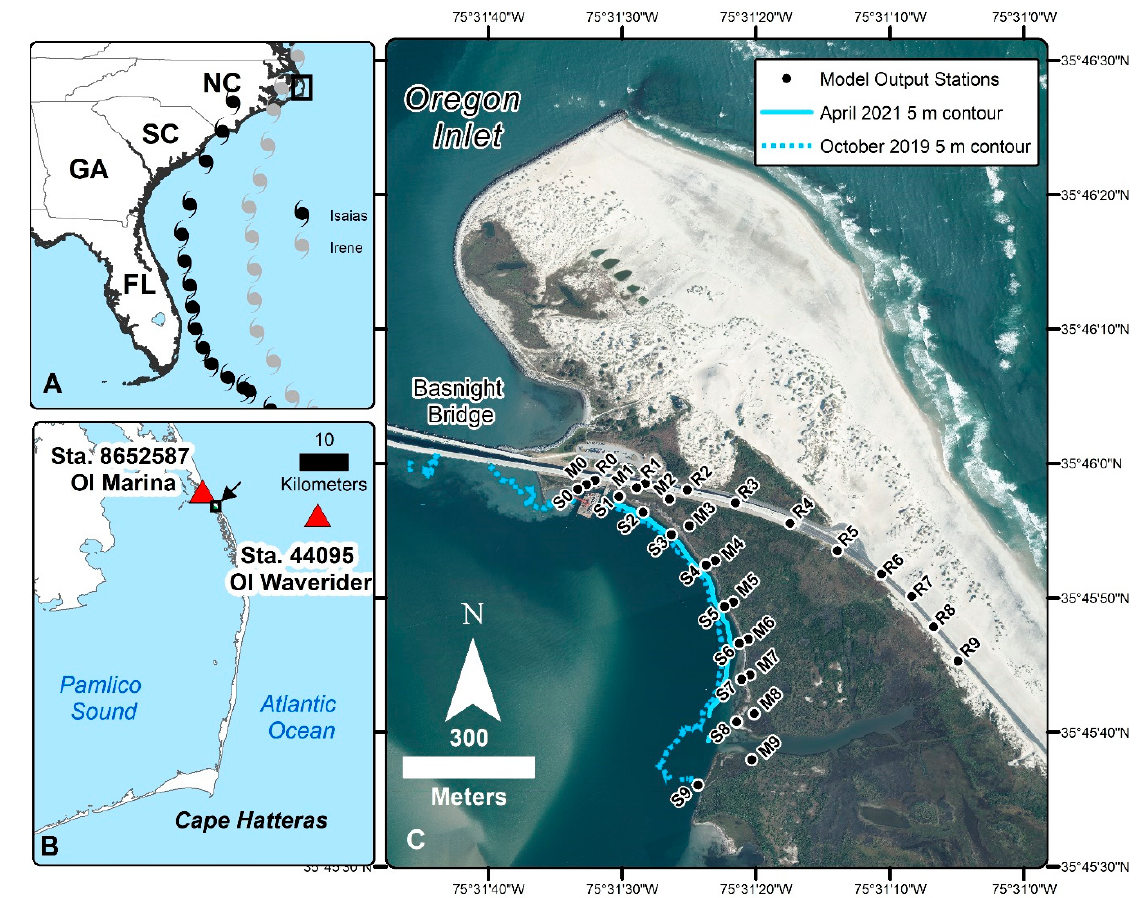
Figure 1. Location of study site along the US East Coast. Region of Panel ( B ) is indicated in panel ( A ); Panel ( B ) shows the location of water level (Sta. 8652587 OI Marina) and wave height (Sta. 44095 OI Waverider) stations employed in this work, with an arrow and black rectangle indicating the location of Panel ( C ). Panel ( C ) shows a detailed view of the study site just south of Oregon Inlet along with the numerical model output stations (black circles) and the location of the 5 m depth contours of the inlet flood channel adjacent to the shoreline as of October 2019 (dotted) and April 2021 (solid). The stations are named according to the convention S = shoreline, M = marsh, and R = roadway.